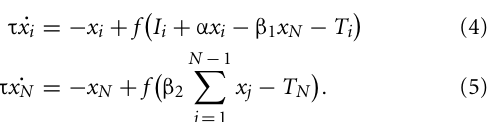
(2003)] curve in response to a given color stimulus is constructed. (D) The DNF dynamics adds lateral interactions between neurons according to Equation (1). The activation of the DNF is shown as a blue line, the red line shows the output (sigmoided activation) of the DNF, the green line is the DPA [same as in (C)